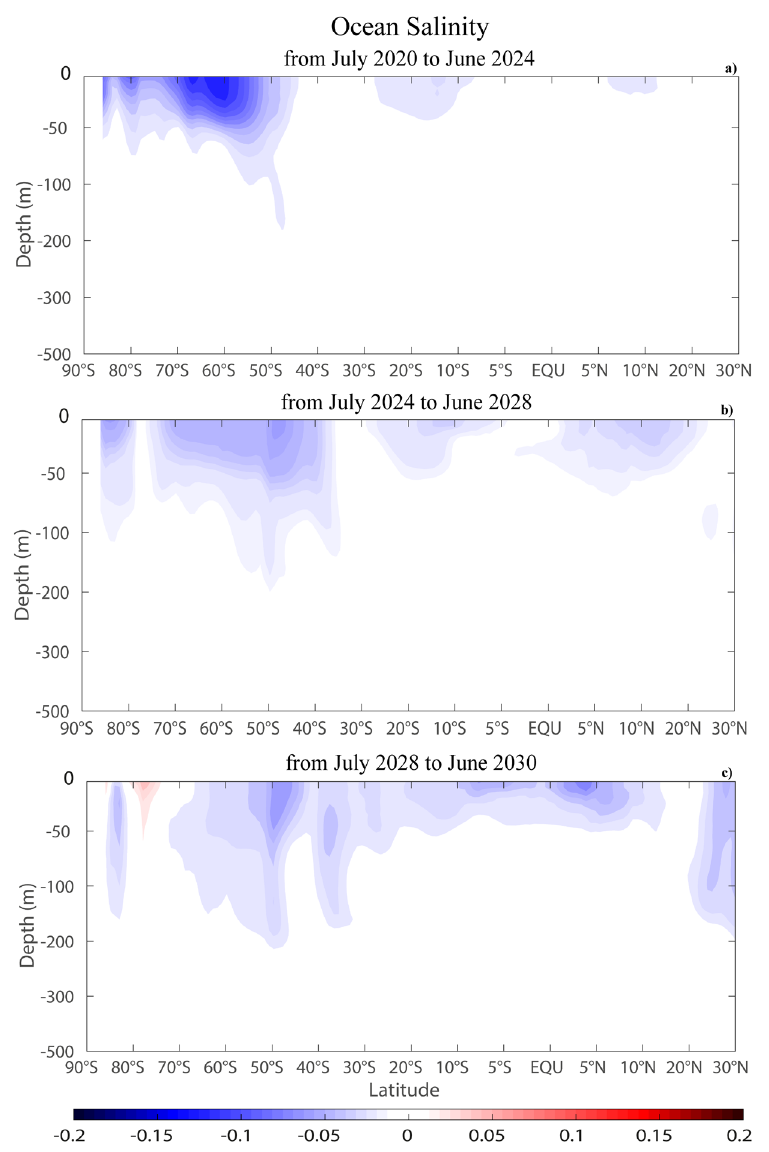
Figure 3. Zonal mean vertical (0–500 m) profile of